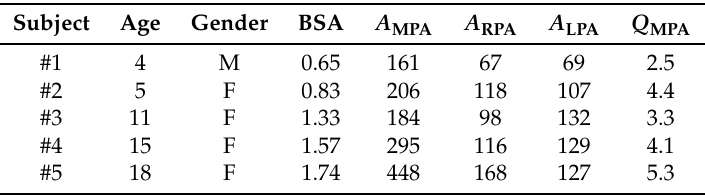
Table 1. Demographic and hemodynamic information of the subjects. BSA is the body surface area in m 2 , A is the vessel area in mm 2 , Q is the flow rate in L/min. The age is in years. A and Q are average values over the cardiac cycle.